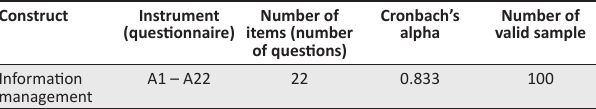
TABLE 6: Structural equation modeling for validity and reliability.